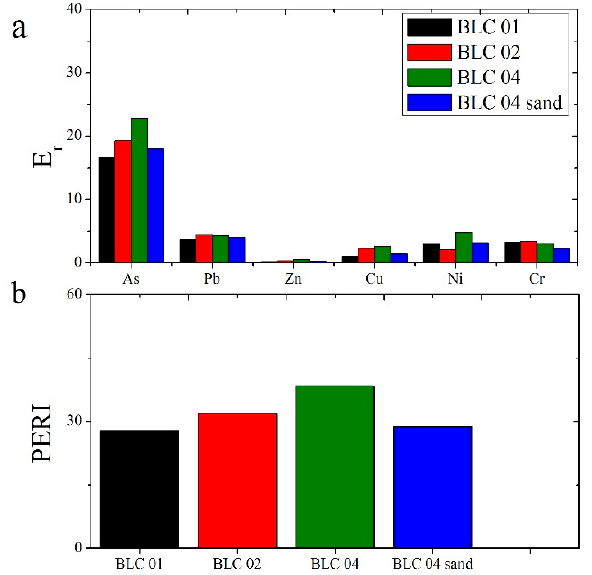
Figure 9. ( a ) Average ecological risk index of each elements and ( b ) average potential ecological risk index for the sediment cores of Batticaloa lagoon.